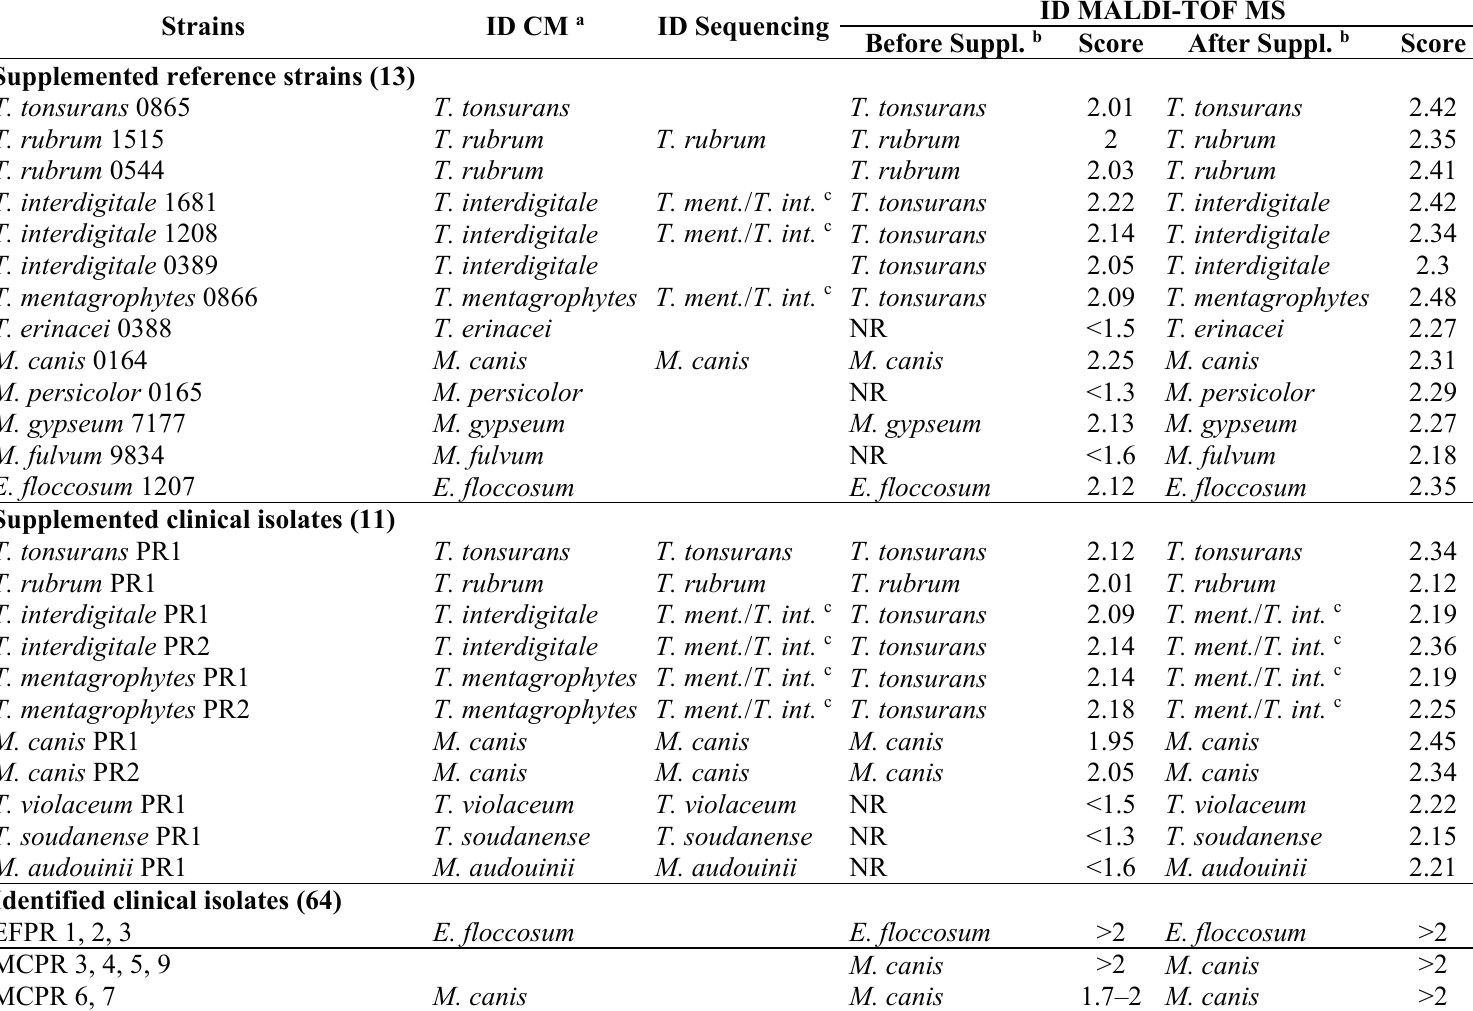
Table 1. Matrix-assisted laser desorption/ionization time-of-flight mass spectrometry (MALDI-TOF MS) results in comparison with conventional methods and